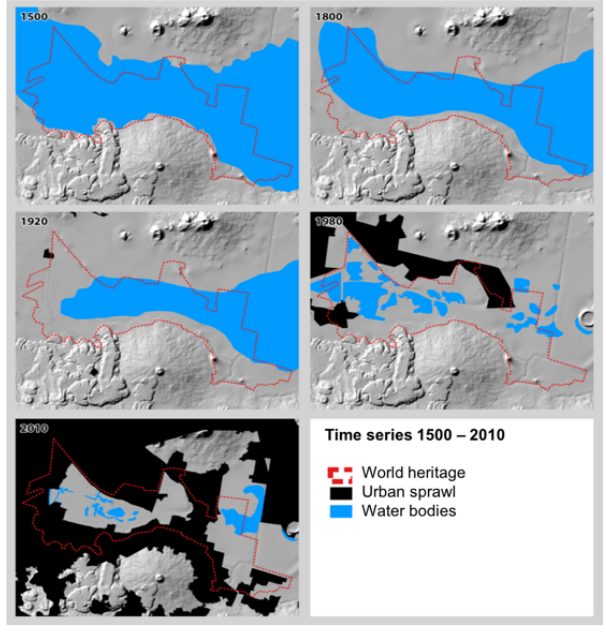
Fig. 2 . Time series 1500-2010. World Heritage perimeter (red), water bodies (blue), and urban sprawl (black) through time (developed by F.